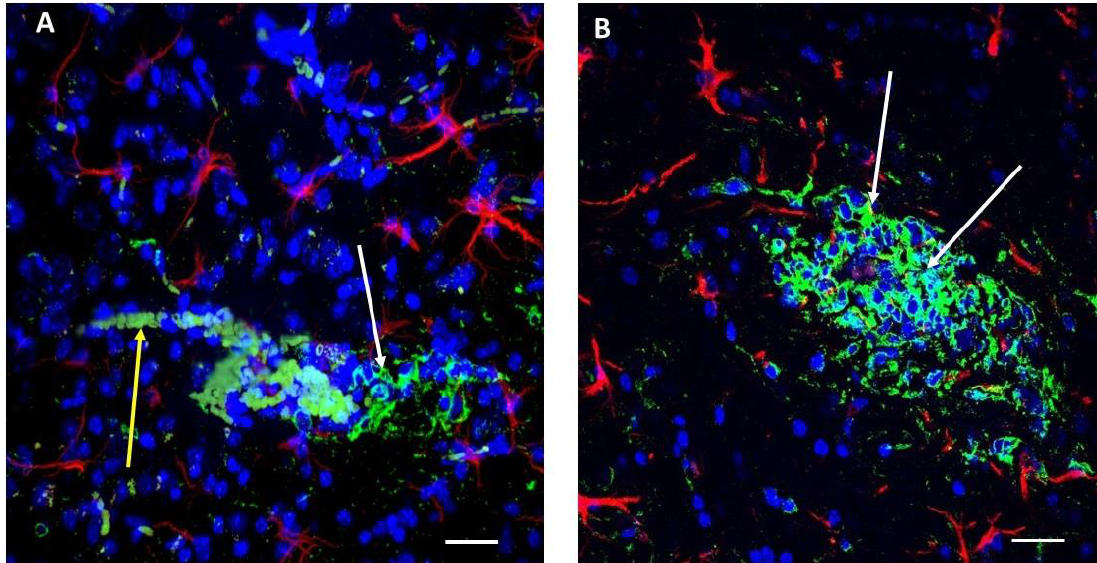
Figure 1. Aβ peptide immunoreactivity (green) in glioma cells and in nearby blood vessels. ( A ) A small glioma tumor near a broken blood vessel. Aβ peptide immunoreactivity (green) visible in glioma cells (white arrow) and in blood vessels. Erythrocytes released from the broken vessel are also marked with Aβ -related immunofluorescence (yellow arrow). ( B ) A larger glioma tumor in which a broken blood vessel passes through the tumor (more clearly visible in the 3D image of this tumor shown in Figure S1B), and white arrows indicate glioma cells marked by green immunofluorescence representing Aβ peptide. For A and B , astrocytes are indicated by immunoreactivity to GFAP (red) and cell nuclei by DAPI staining (blue). Scale bar, 20 µm. (See also supplemental confocal 3D images of the same tumors in Figure S1A,B, respectively).